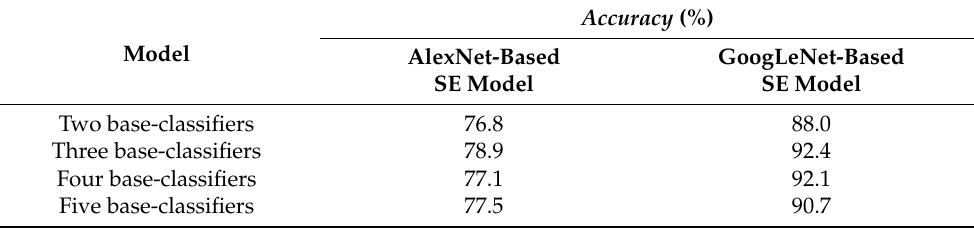
Table 6. Classification accuracies of the stacking ensemble (SE) models with different numbers of base-classifiers for test